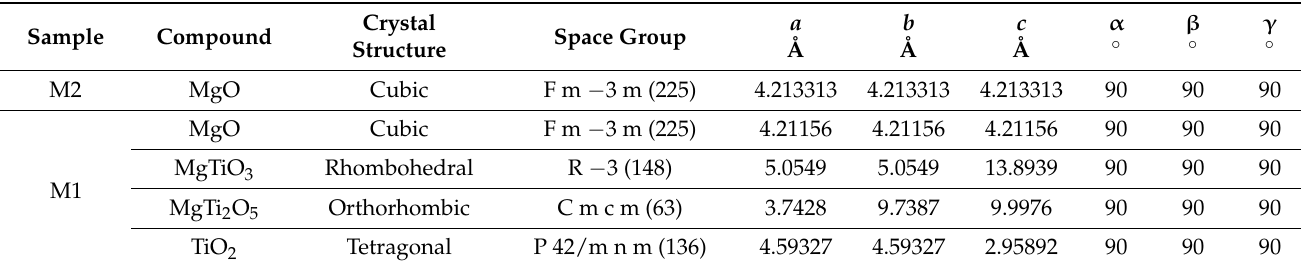
Table 7. Cristallographic parameters obtained from XRD analysis for samples of pure calcined brucite (M2) and brucite mixed with titania (M1), both heat-treated at 1100 ◦ C for 1